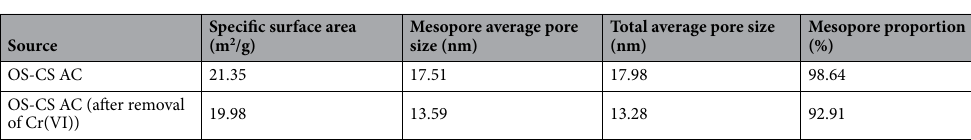
Table 2. Surface area and pore volume of OS-CS